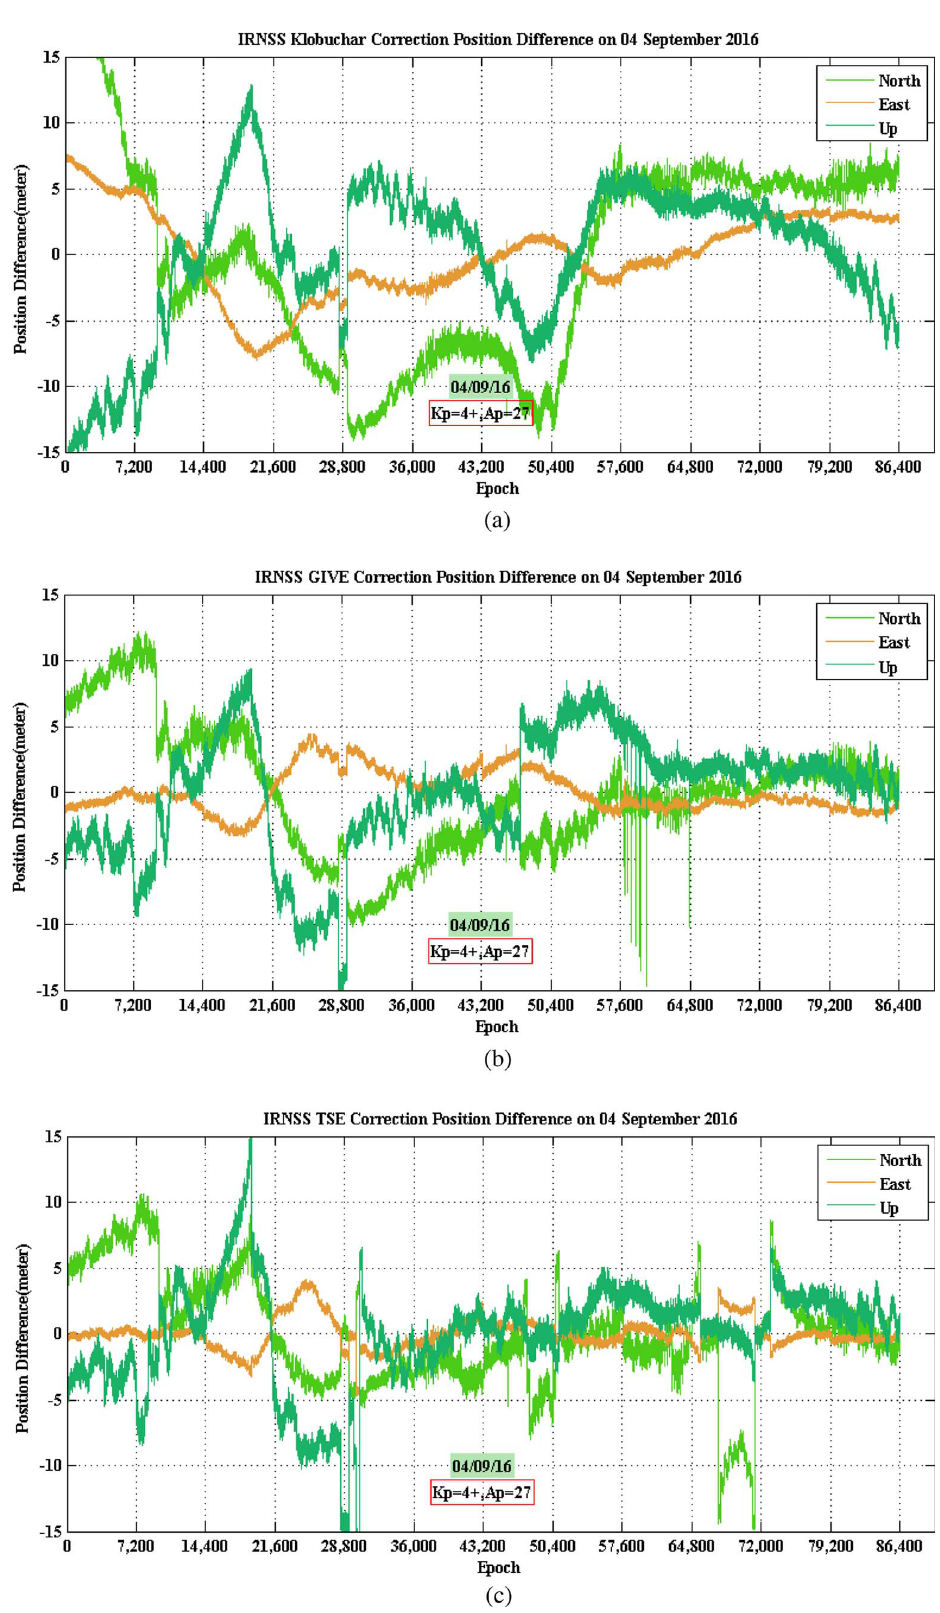
Fig. 16. Position Error (a) IRNSS with Dual frequency Correction, (b) IRNSS with Klobuchar Correction, (c) IRNSS with TSE Correction, (d) IRNSS with GIVE Correction, and (e) IRNSS + GPS Correction on